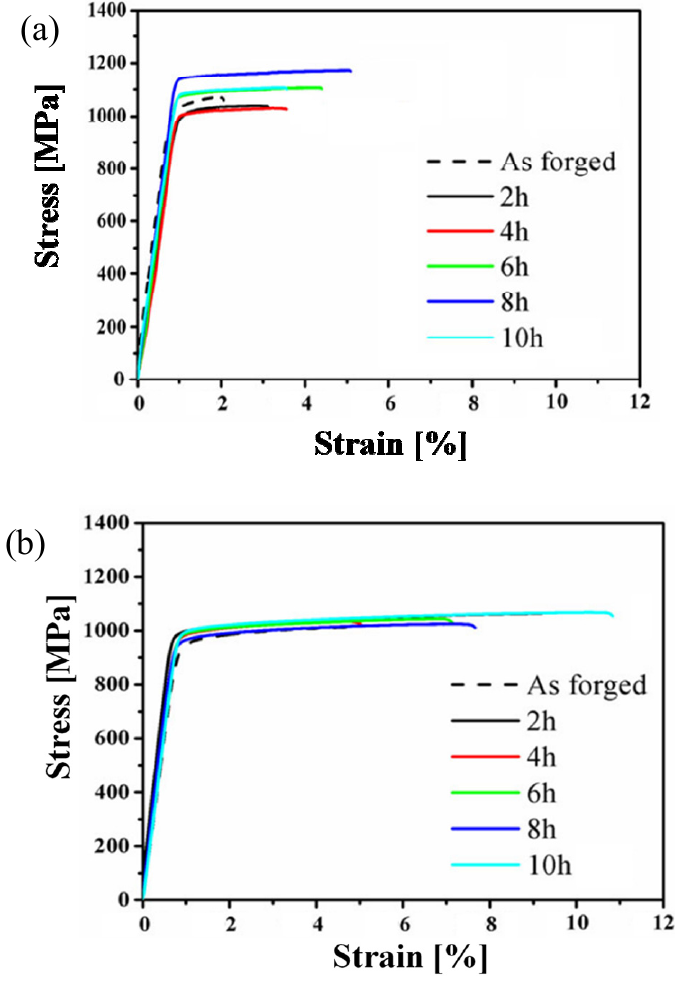
Figure 3. Representative stress–strain curves of the Ti-5Al-2.5Fe alloy forged at ( a ) 950 °C and ( b ) 1250 °C without and with annealing treatment.